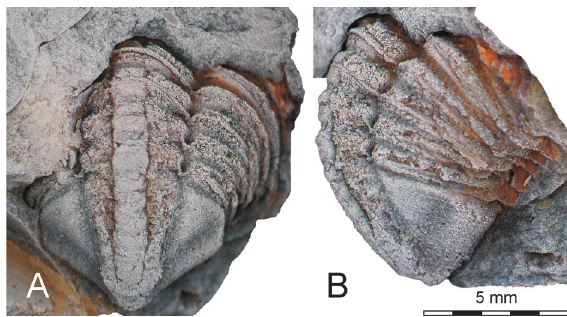
Fig. 4. Internal mould of Colpocoryphe bohemica (Van ě k, 1965) from the Šárka Formation (Middle Ordovician, Darriwilian = Oretanian Regional Stage); West-Bohemian Museum in Plze ň , WBM S 06 160; fields near Mýto (locality 1 in Fig. 1B). A , dorsal view. B , lateral